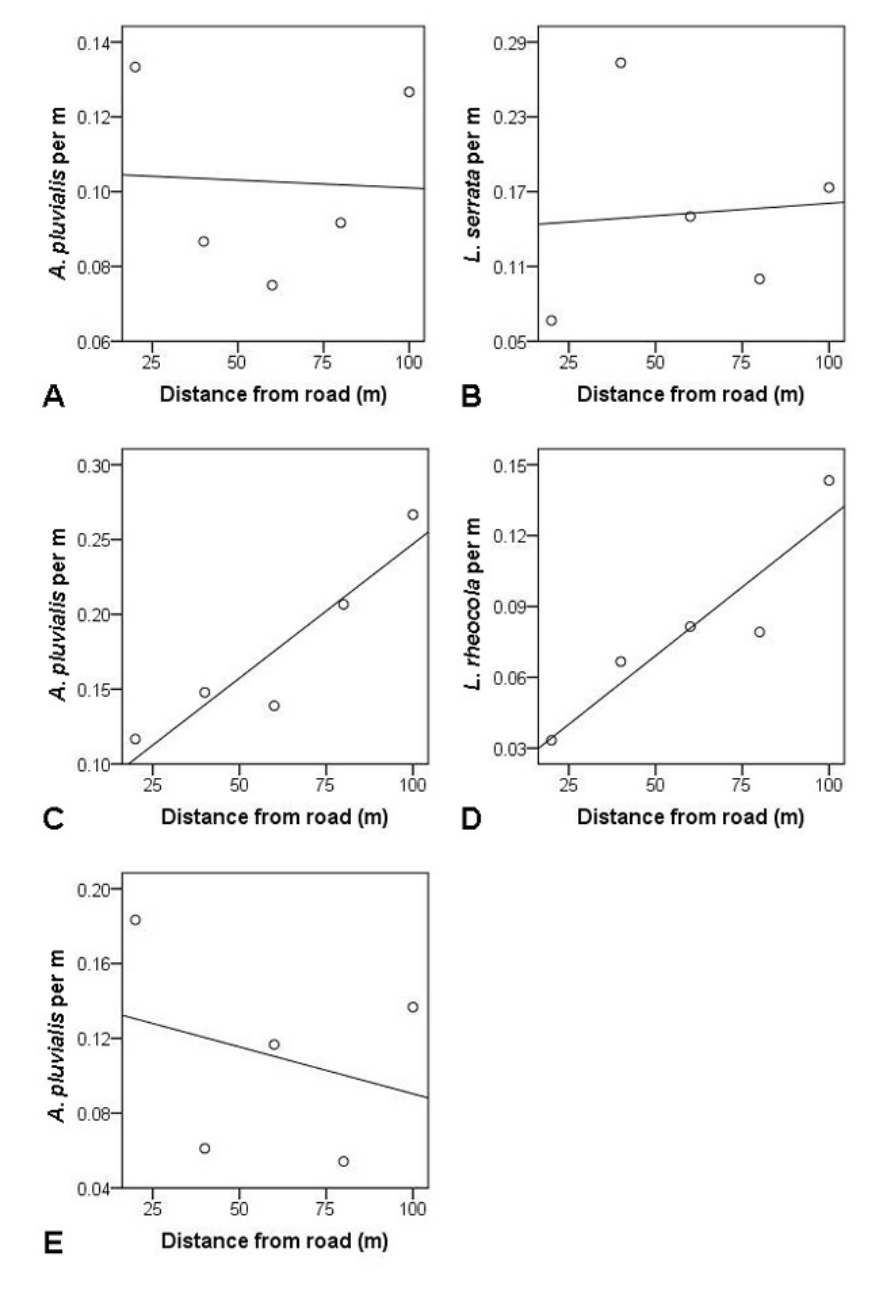
Fig. 2 . Average abundance of species versus perpendicular distance to the road. (A) A. pluvialis on the upper Avondale Creek transect, (B) L. serrata on the upper Avondale Creek transect, (C) A. pluvialis on the downstream Streets Creek transect, (D) L. rheocola on the upstream Streets Creek transect, (E) A. pluvialis on the upstream Streets Creek